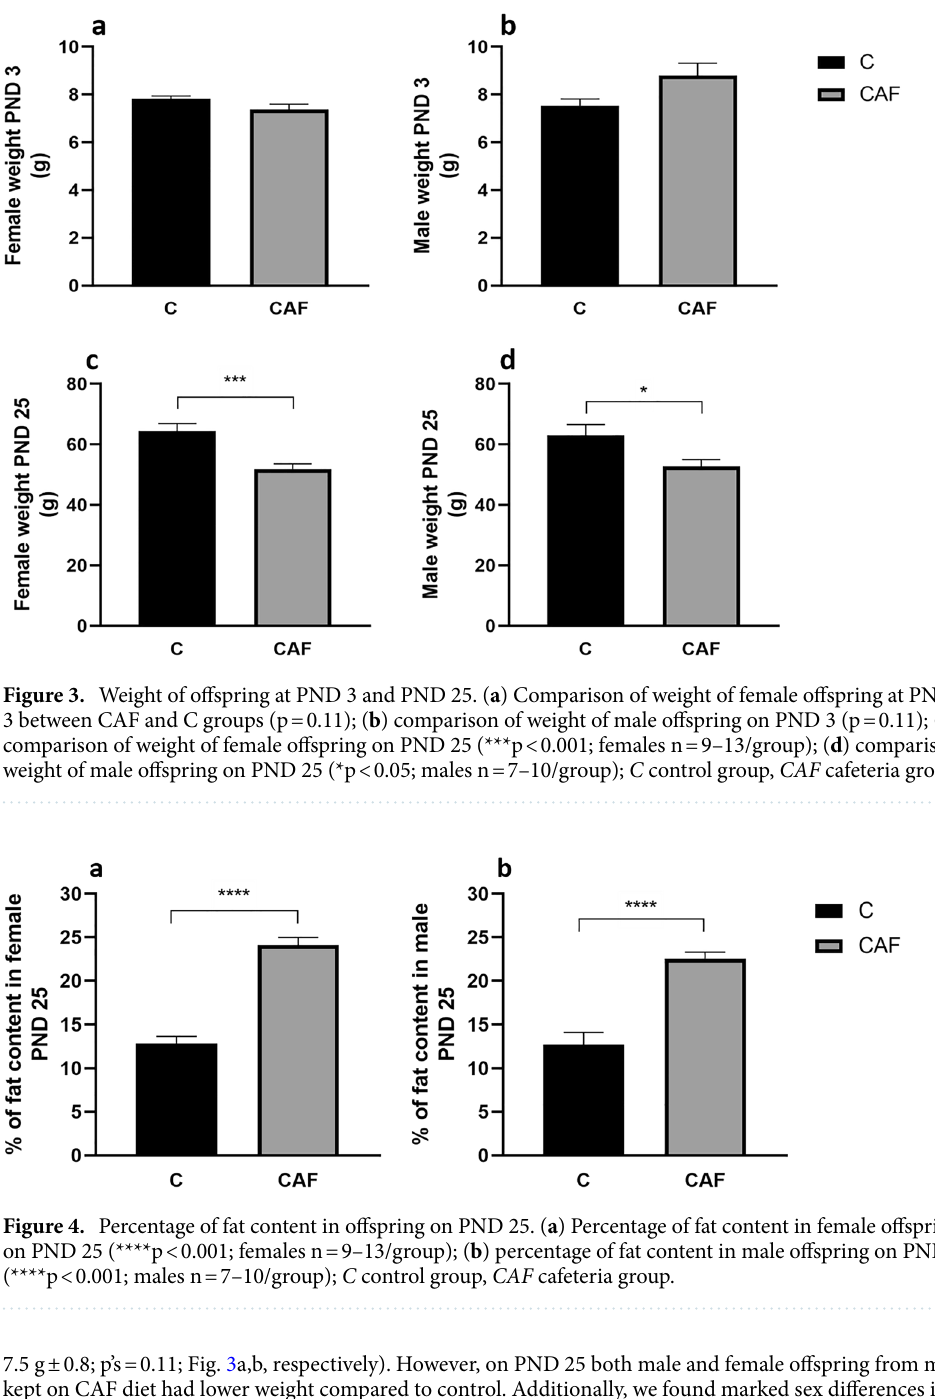
7.5 g ± 0.8; p’s = 0.11; Fig. 3a,b, respectively). However, on PND 25 both male and female offspring from mothers kept on CAF diet had lower weight compared to control. Additionally, we found marked sex differences in body weight of pups. Females offspring from CAF group weighed about 20% less compared to controls (for CAF: 51.8 g ± 2.9; for C: 64.4 g ± 2.9; p’s < 0.001; n = 9–13; Fig. 3c). Whereas, male offspring from CAF group weighed about 16% less than these from C group (for CAF: 52.7 g ± 4.0; for C: 63.0 g ± 4.0; p’s < 0.05; n = 7–10; Fig. 3d). There were also significant differences in percentage of fat in offspring on PND 25. Both female and male offspring from mothers kept on a CAF diet had higher percentage of fat compared with controls (females: for CAF: 24.1 g ± 1.3, for C: 12.8 g ± 1.3, n = 9–13; males: for CAF: 22.5 g ± 1.5, for C: 12.7 g ± 1.5, n = 7–10; p’s < 0.001; Fig. 4a,b, respectively). CAF diet altered metabolic parameters in offspring on PND 25 in a sex‑specific manner. Female, but not male off- spring from mothers kept on a CAF diet had a 14.5% higher blood glucose level when comparing to respective C groups (females: for CAF: 141.8 mg/dl ± 7.5, for C: 123.8 mg/dl ± 7.5; p < 0.05; Fig. 5a; males: for CAF: 143.8 mg/ dl ± 9.1, for C: 126.0 mg/dl ± 9.1; p = 0.07; Fig. 5b; n = 5/sex/group).